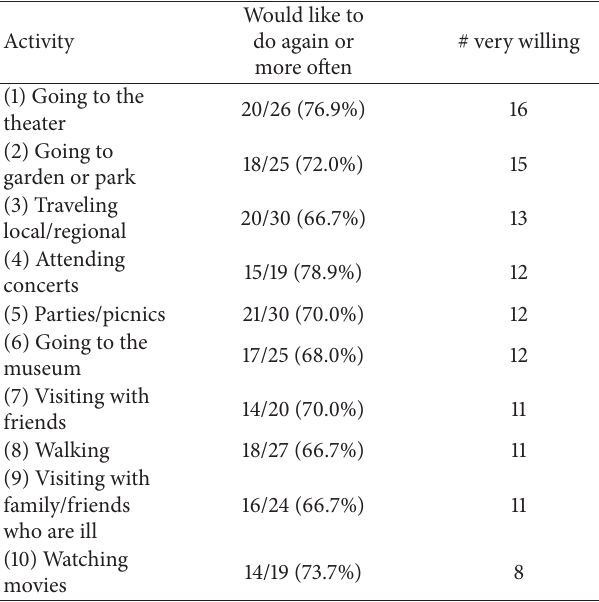
Table 5: Top ten activities participants would like to do again or more